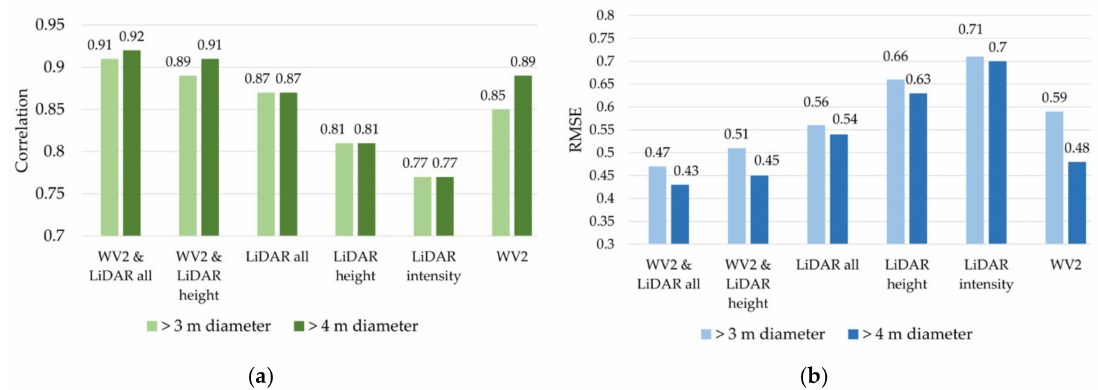
Figure 12. Correlations ( a ) and RMSE ( b ) of WV2 and LiDAR attributes for an RF regression on seven stress symptom levels. The performance was tested for crowns with a mean diameter larger than 3 m (light colour, total 1089) and larger than 4 m (dark colour, total 895). The RF regression was carried out in 1000 repetitions for a random three-fold split with a tree depth of eight. Table 8. Selected attributes for a stress analysis with WV2 and LiDAR attributes for seven stress levels and the first symptoms of stress (level 1 to 3) for crowns with a diameter larger than 4 m. The attribute importance in % is based on an RF regression in a 10-fold cross